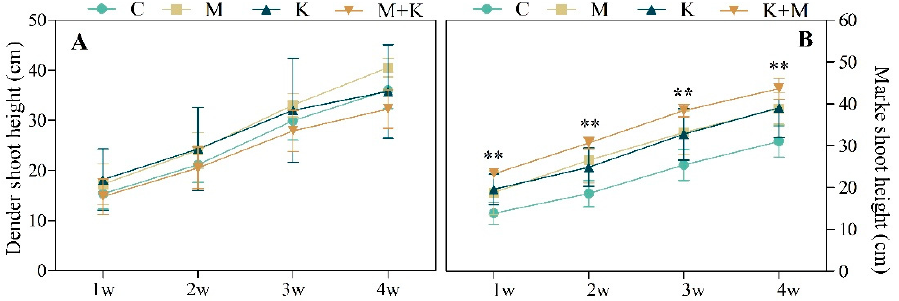
Figure 2. Shoot height in Populus ‘Dender’ ( A ) and Populus ‘Marke’ ( B ) cultivars detected during the 4-weeks inoculation experiment. Ctrl (control): non-inoculated cuttings; M: Methylobacterium